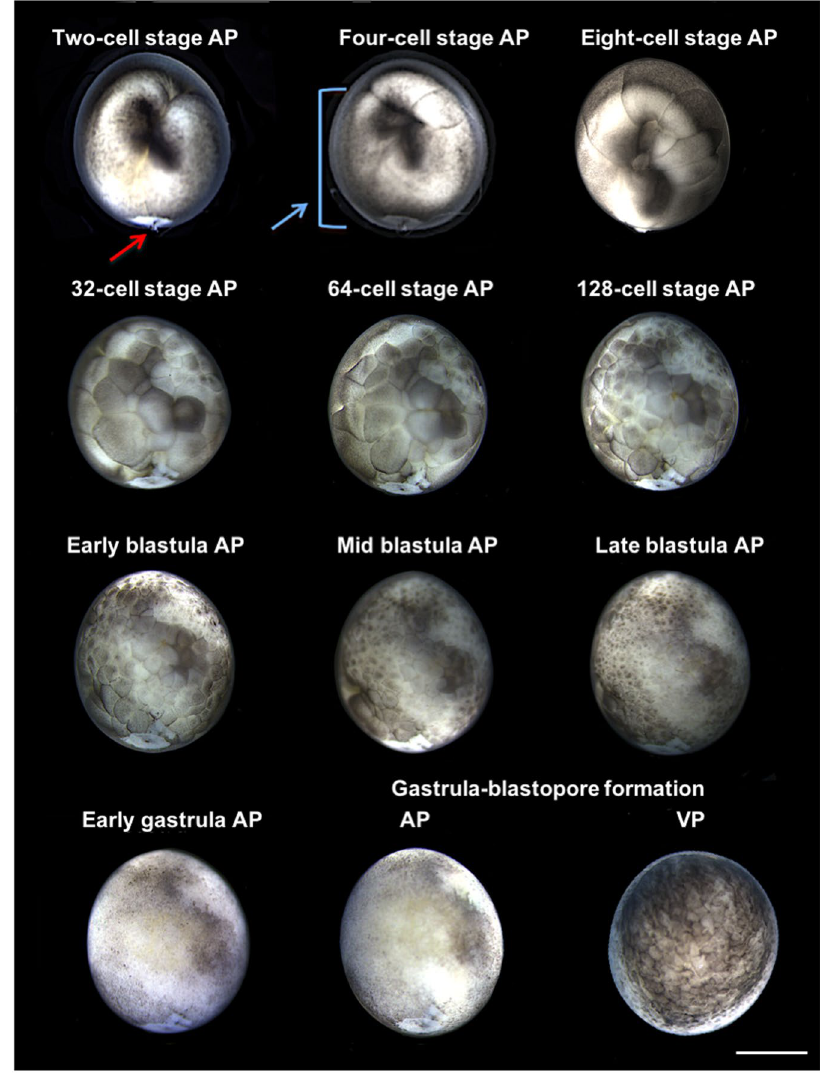
Figure 4. Development of a Russian sturgeon mNT that exhibit large blastomeres together with the normal size ones. The red arrow shows an injury position due to microinjection that remains throughout the development (gastrula-blastopore formation). The blue arrow is showing the area where the large blastomeres were created, mostly on the center and left side of the mNT. These blastomeres formed at the 4-cell developmental stage and were no longer visible in the late blastula stage. Animal pole (AP), vegetal pole (VP), scale bar corresponds to 1 mm.